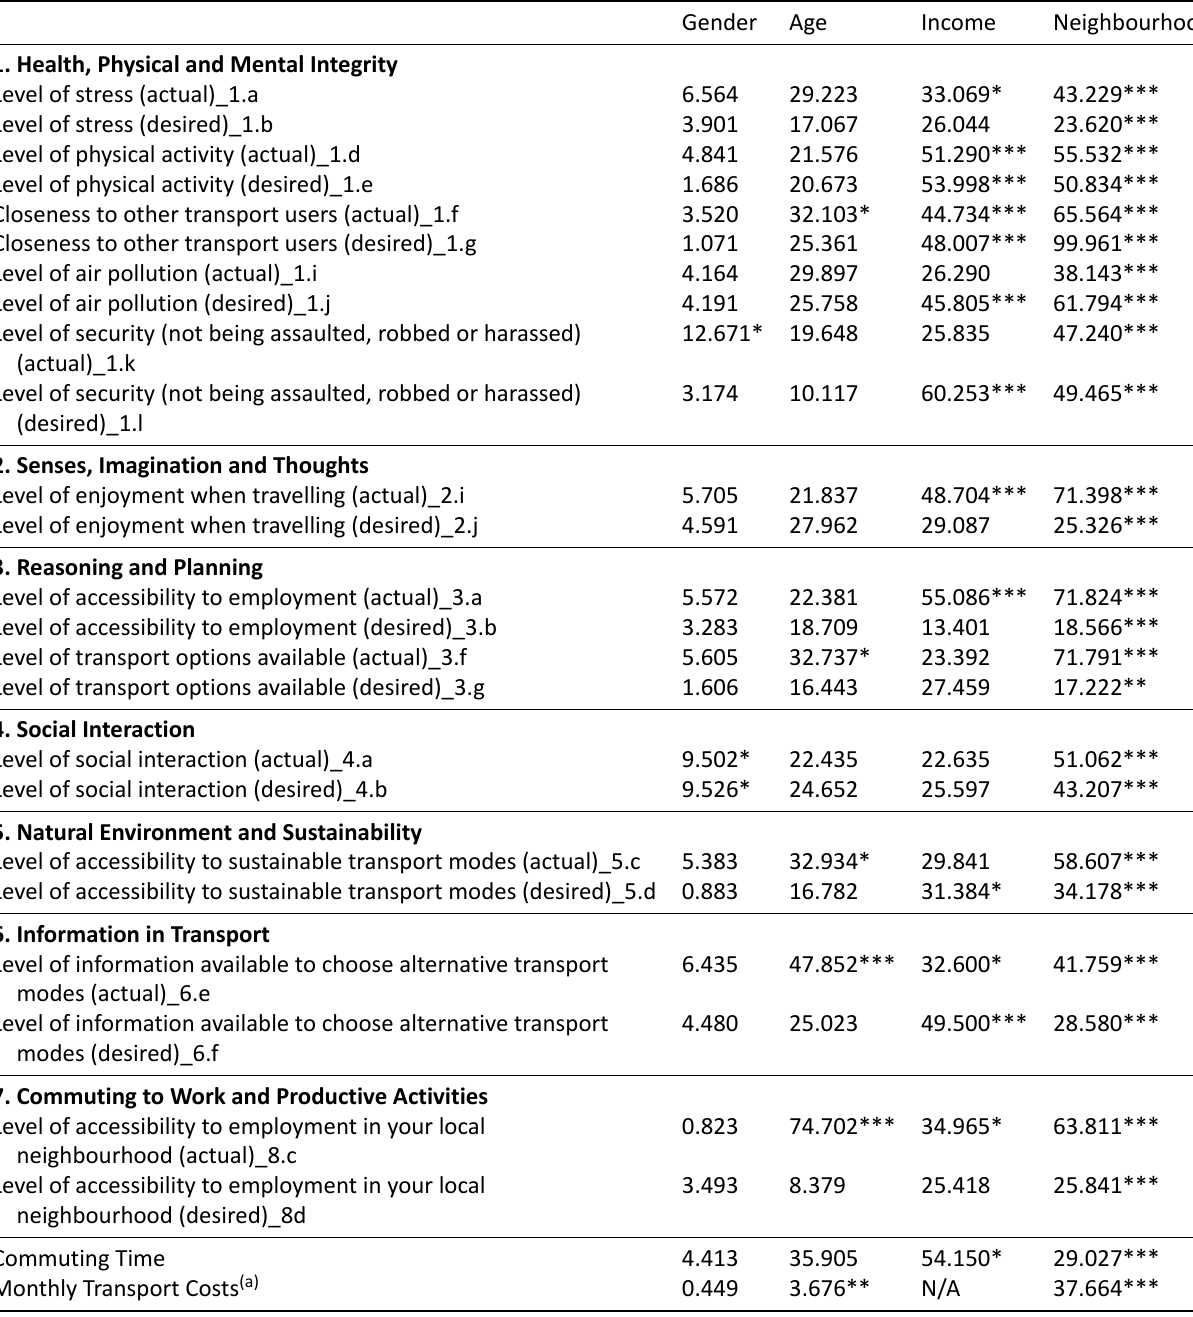
Table 2. Summary test statistics (Chi-squared and F Test) for capabilities and